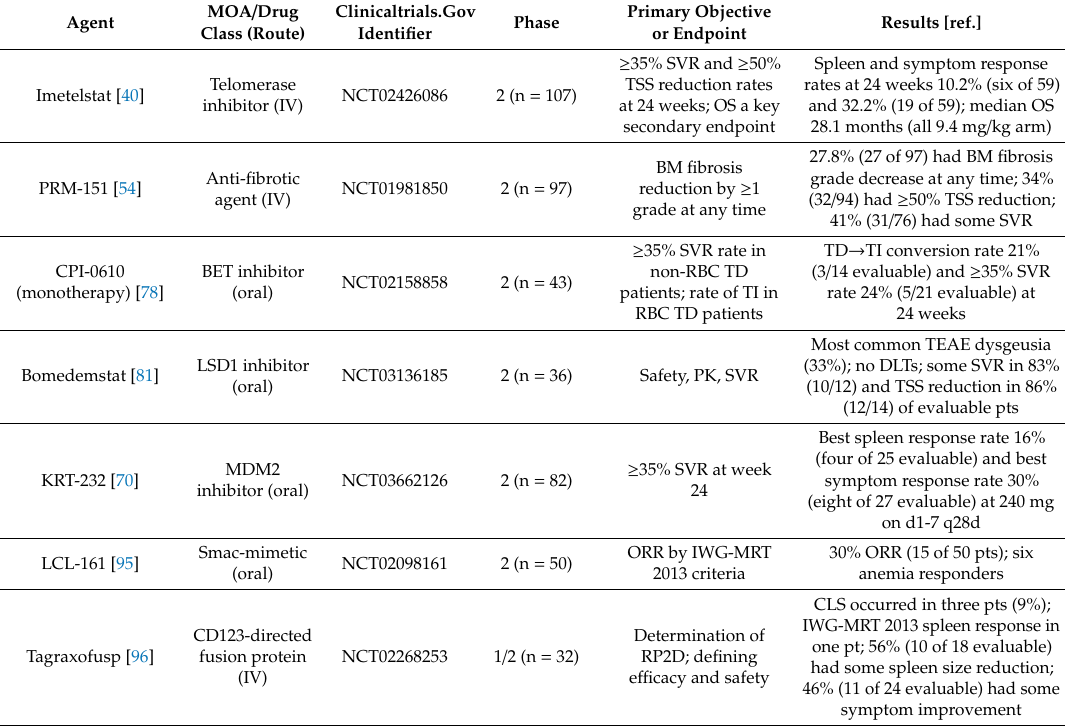
Table 3. Selected novel, single-agent, non-JAK inhibitor approaches in clinical trials in MF. MOA / Drug Agent Class